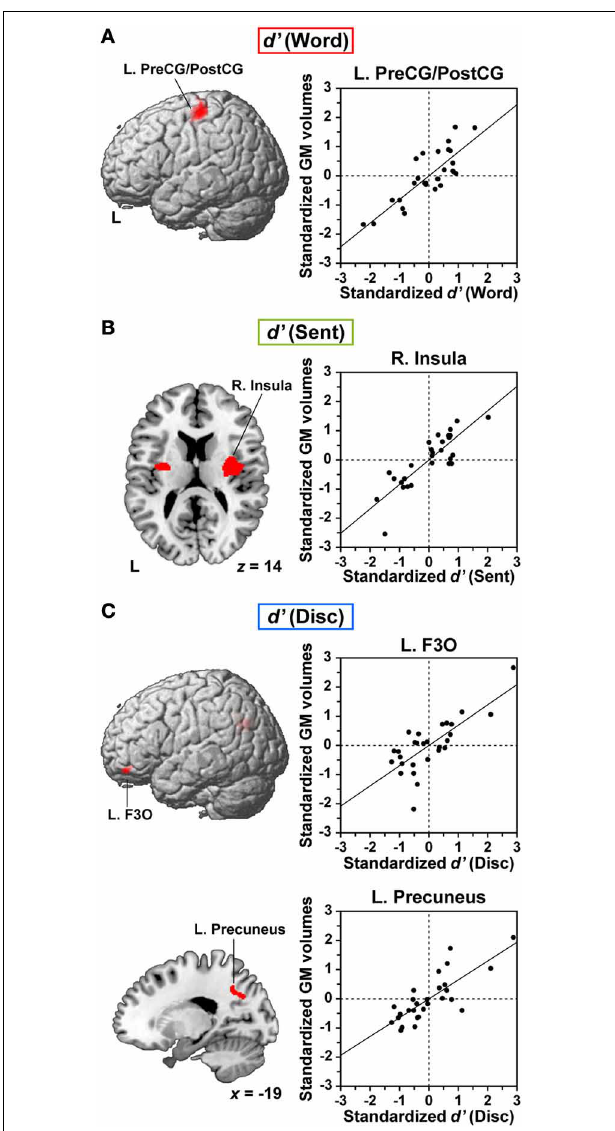
FIGURE 4 | Anatomical signature for the linguistic proficiency of individuals in JSL. (A–C) Correlations between regional gray matter (GM) volumes and individual performances ( d (cid:2) ) of the Word (A) , Sent (B) , and Disc (C) tasks. In the left column, correlation maps (FDR-corrected p < 0 . 05) are projected onto the left lateral surfaces of a standard brain for the L. PreCG/PostCG (A) and for the L. F3O (C) . An axial slice ( z = 14) is shown for the largest cluster in the right (R.) insula, as well as for the second largest cluster in the left insula (B) . A sagittal slice ( x = − 19) is shown for the largest cluster in the L. precuneus (C) . In the right column, scattered plots and regression lines are shown for partial correlations between the standardized d (cid:2) of each task and the standardized GM volumes at the peak voxel, after removing the effects of age, LQ, gender, age of hearing loss, AOAs of JSL, AOAs of JPN, and d (cid:2) of the R